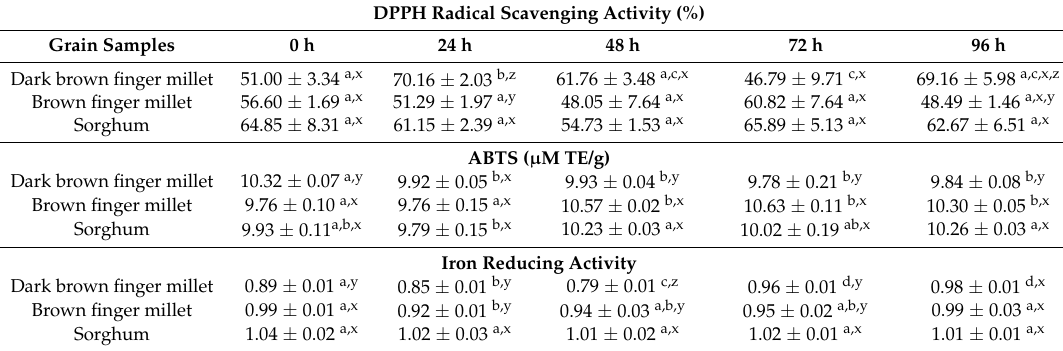
Table 4. Effect of malting period on antioxidant activity of finger millet and sorghum extracts obtained using 1%